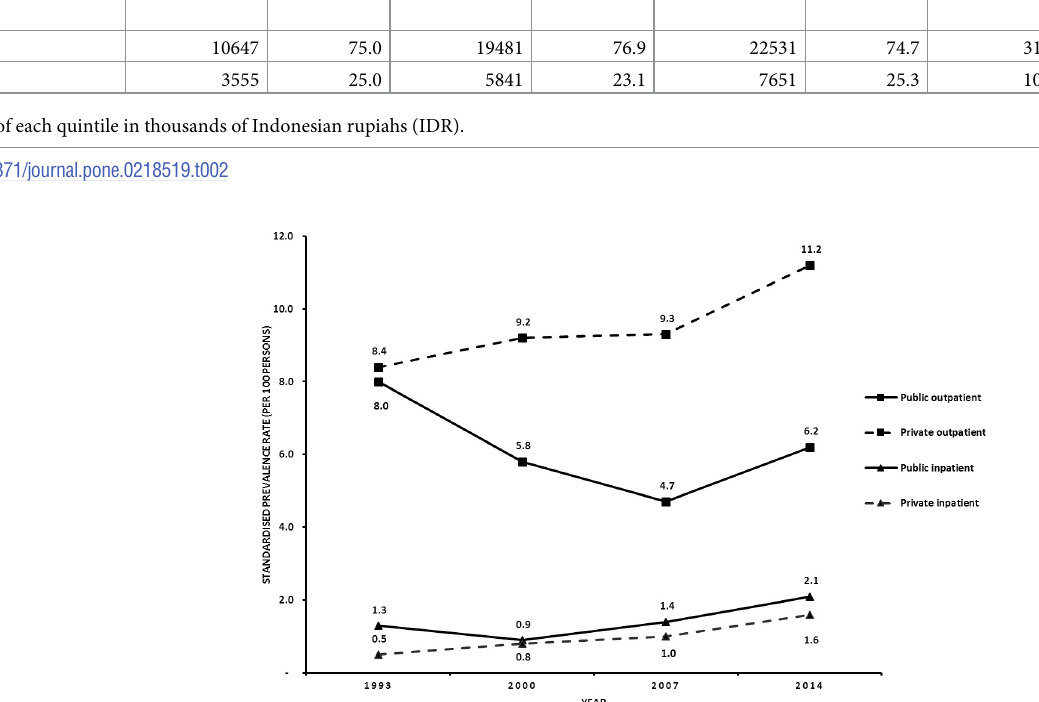
PLOS ONE | https://doi.org/10.1371/journal.pone.0218519 June 25,